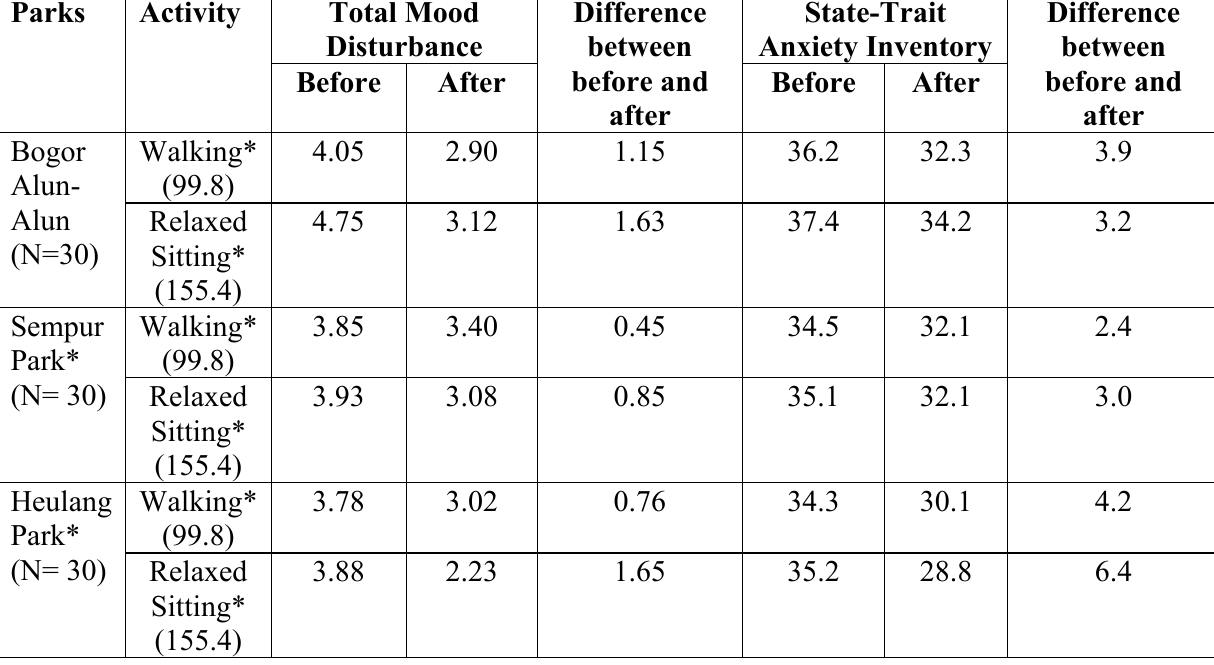
Table 3. The results of the difference between total mood disturbance and state anxiety before-after walking and relaxed sitting at the three locations.